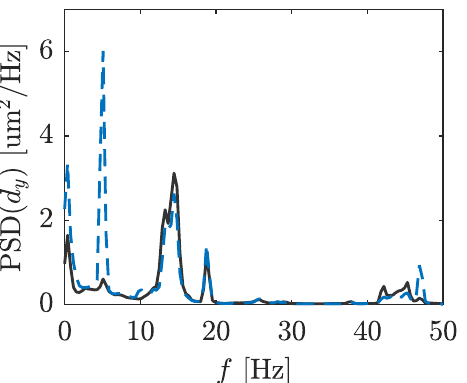
Figure 4. Comparison of the power spectra of the wall-normal deformation, d y , between the unforced (solid) and forced (dashed) studies. Data correspond to the leading-edge FOV and have been spatially-averaged over x and z